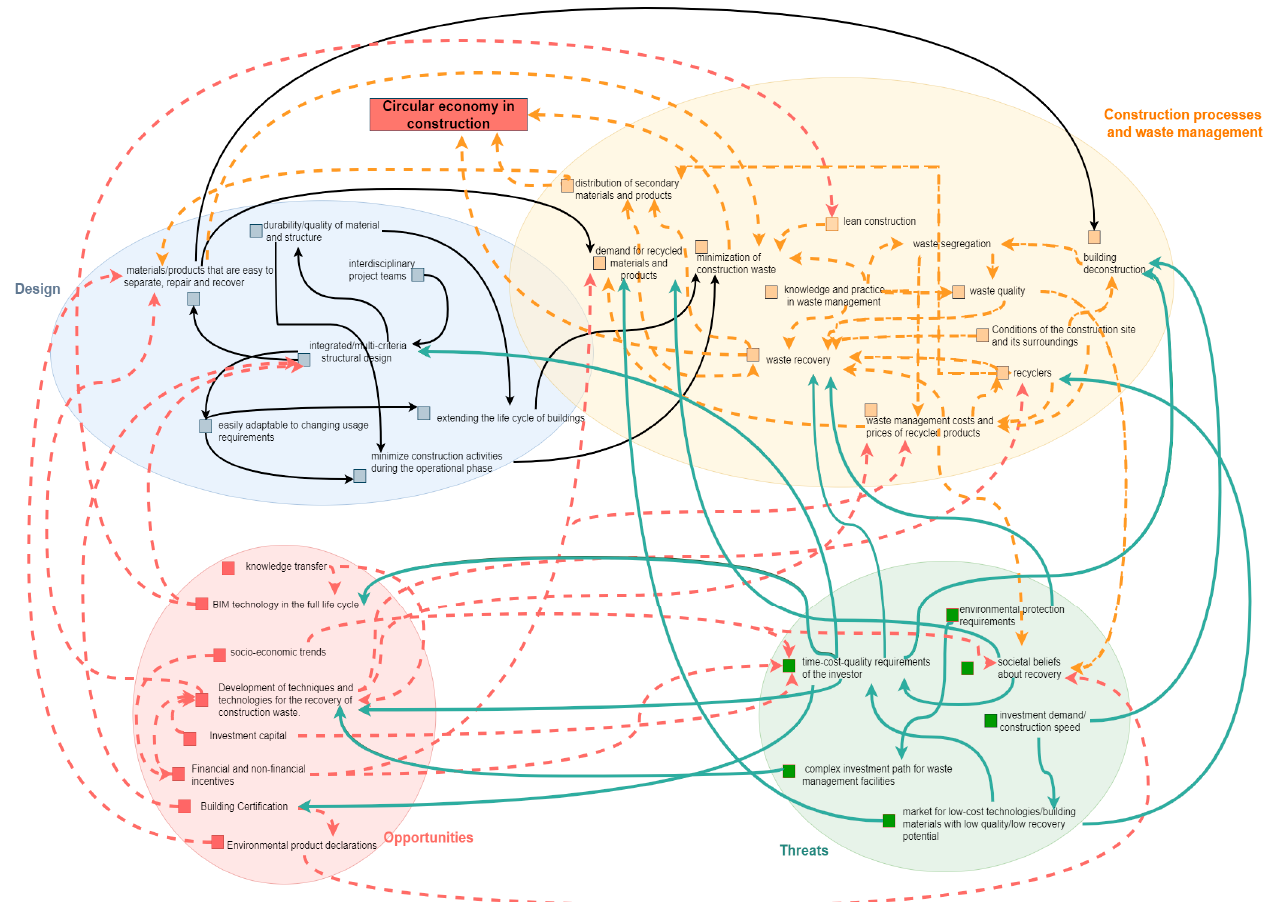
Figure 4. Relationships between factors.